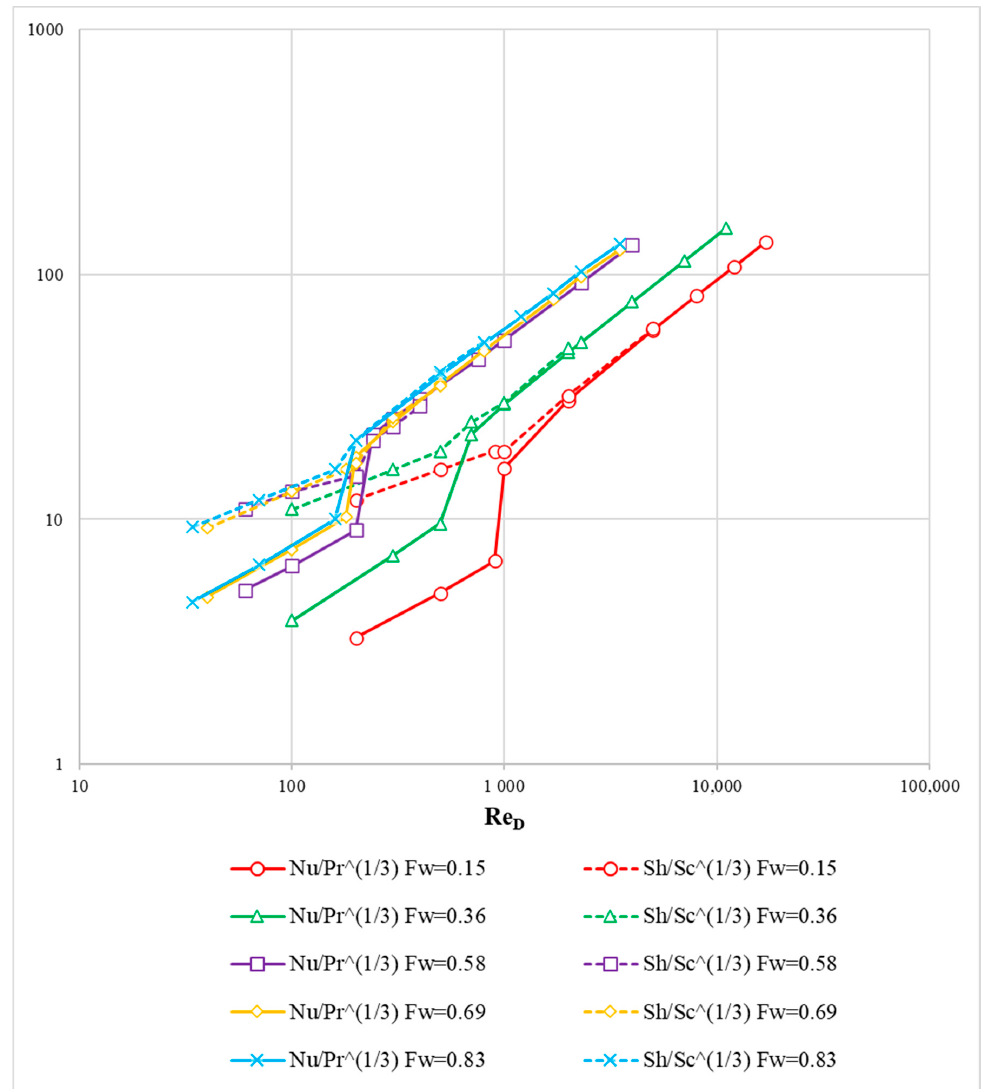
Figure 12. Comparison of heat and mass transfer phenomena in wavy-walled tubes. Yongning et al. has reported that within the laminar flow regime the mass transfer effects in the wavy-walled tube increases with a slope of 1/3 with respect to the Reynolds number as shown in Figure 12. It can be seen that heat transfer effects also increase with respect to the Reynolds number with a slope of 1/2 that is higher than 1/3. This suggests that the Nusselt number in wavy-walled tubes increases at a faster pace (by 50%) compared to mass transfer effects. These results suggest that wavy-walled tubes can serve as a better heat transfer augmentation geometry for higher Prandtl number liquids. While for the turbulent flow regime, it can be observed from Figure 12 that heat and mass transfer effects show the same results with an average deviation of less than 5%. Hence, it can